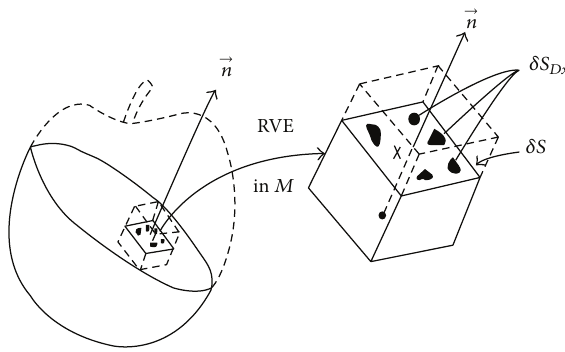
Figure 2: Damaged RVE in a damaged body.